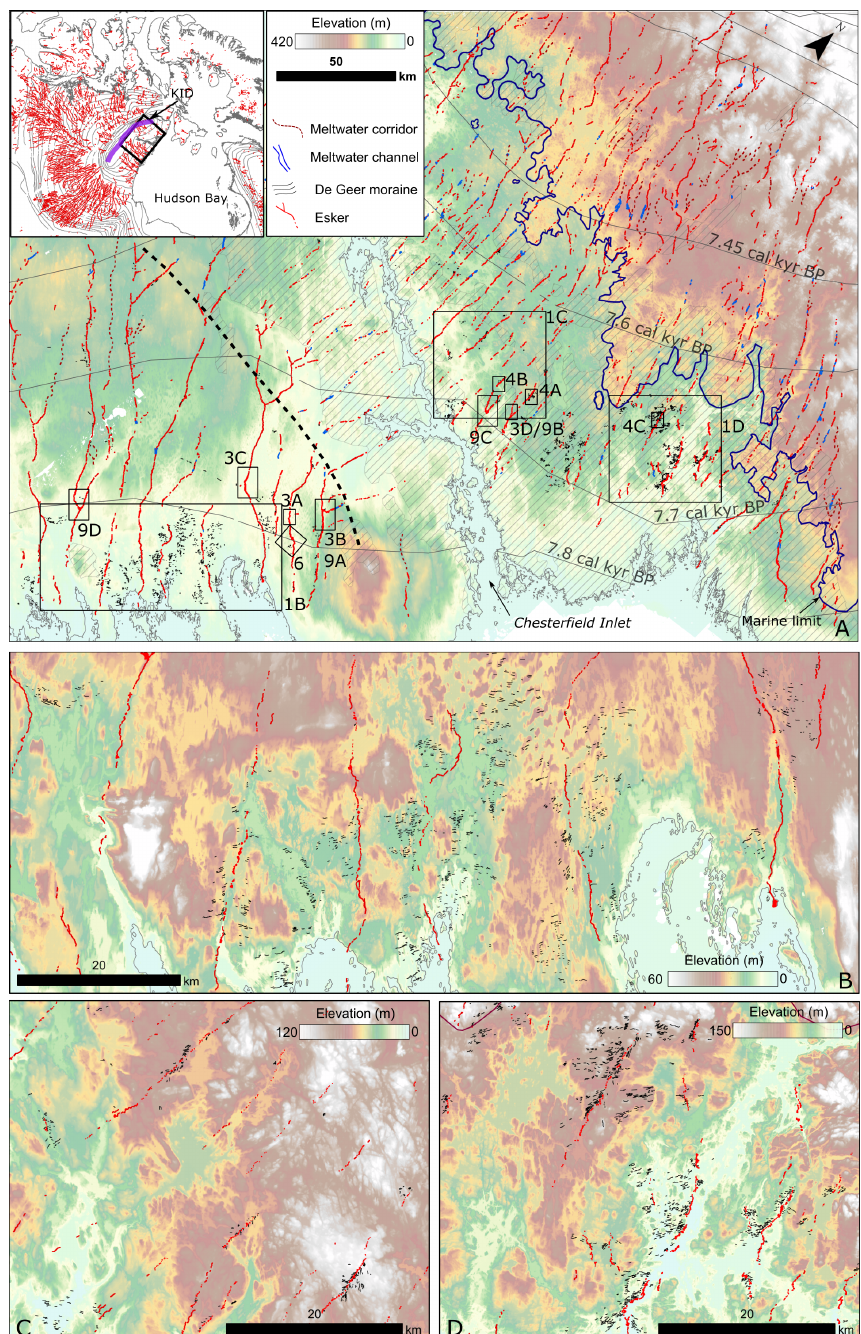
Figure 1. (a) Glacial geomorphological map of meltwater features and De Geer moraines in central Nunavut, NW of Hudson Bay. Inset map shows location of study area, Keewatin Ice Divide (KID) (purple line), and previous regional mapping of eskers (Storrar et al., 2013). Black dashed line indicates the approximate axis of a re-entrant along which we interpret the two ice masses pulled apart. Solid dark blue line is the marine limit modified and extended from Randour et al. (2016). Grey hatched lines are areas of exposed bedrock, and annotated solid grey lines are ice-margin positions extrapolated from Dyke et al. (2003). (b–d) Zoomed-in maps showing the pattern of De Geer moraines and eskers. DEMs created by the Polar Geospatial Center from DigitalGlobe, Inc.,